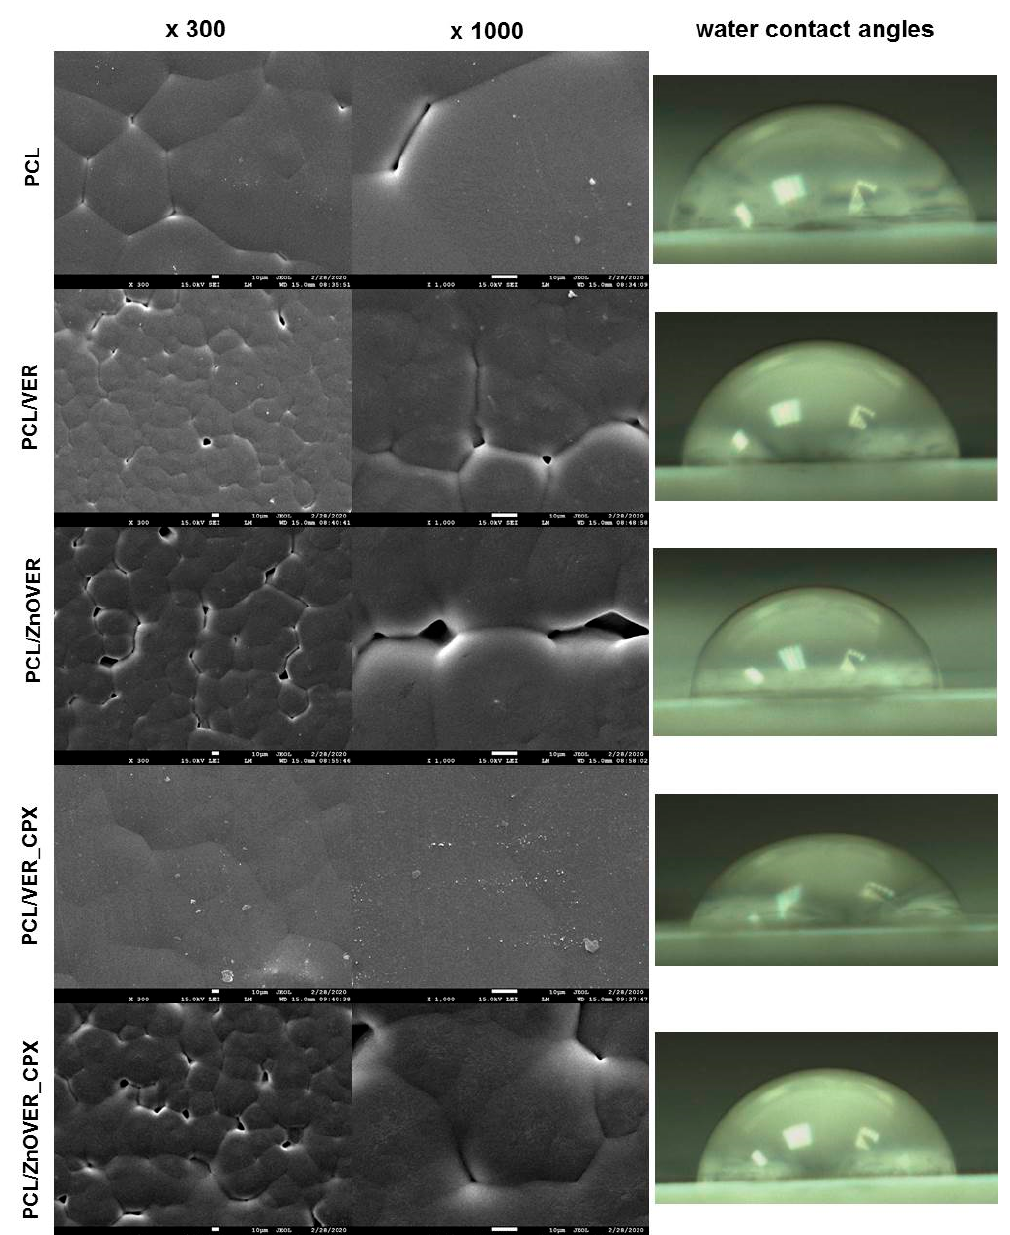
Figure 7. SEM images of pure PCL thin film and thin PCL/clay nanocomposite films (magnification × 300 and × 1000) with water contact angles.